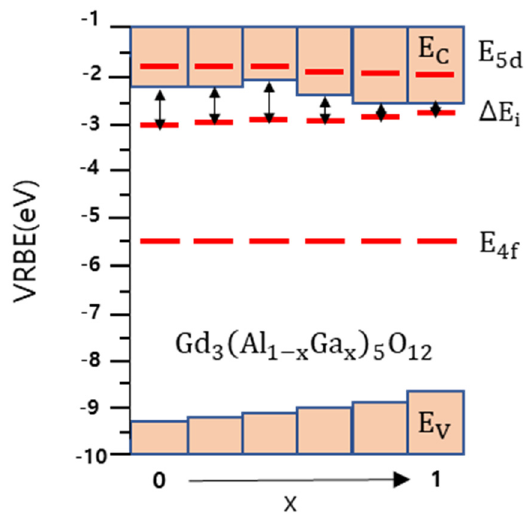
Figure 2. Vacuum referred binding energy (VRBE) for electrons in the 4f ground state and first two 5d excited states of Ce 3+ in RE 3 (Al 1 − x Ga x ) 5 O 12 garnet compounds. Reproduced with permission of Ref. [15].